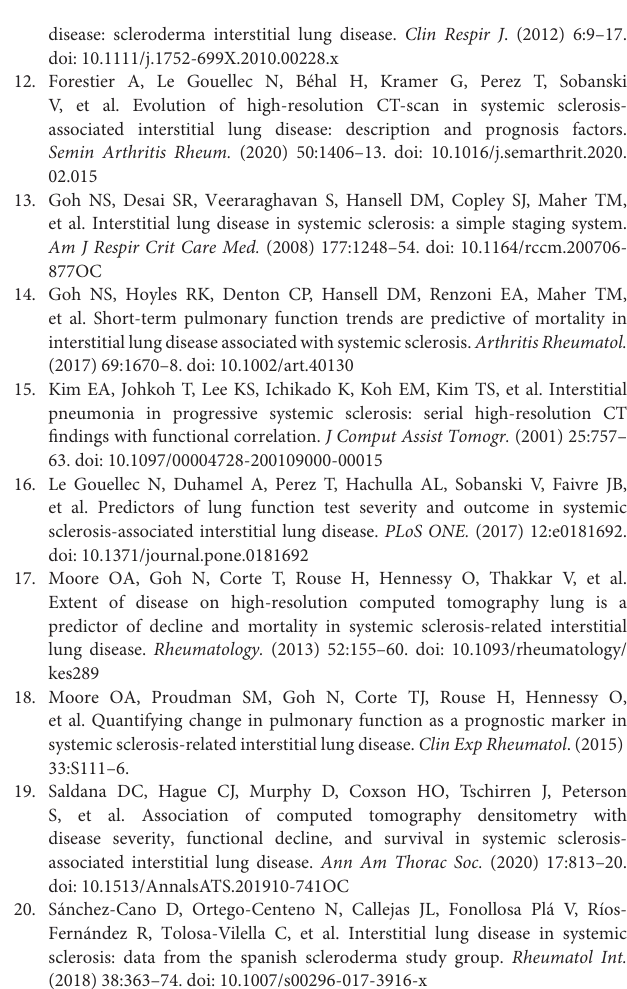
Supplementary Table 3 | Predictors of mortality in ILD-SSc, multivariate